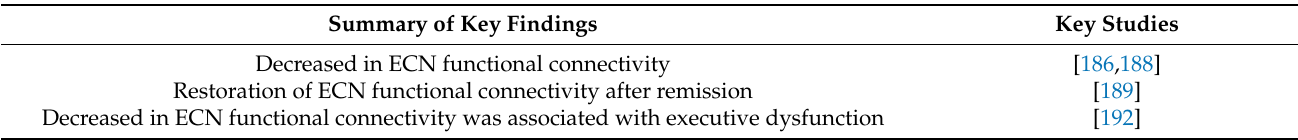
Table 3. Summary of key findings of rs-fMRI studies associated with the executive control network (ECN) in late-life depression (LLD) patients included in the review. Summary of Key Findings